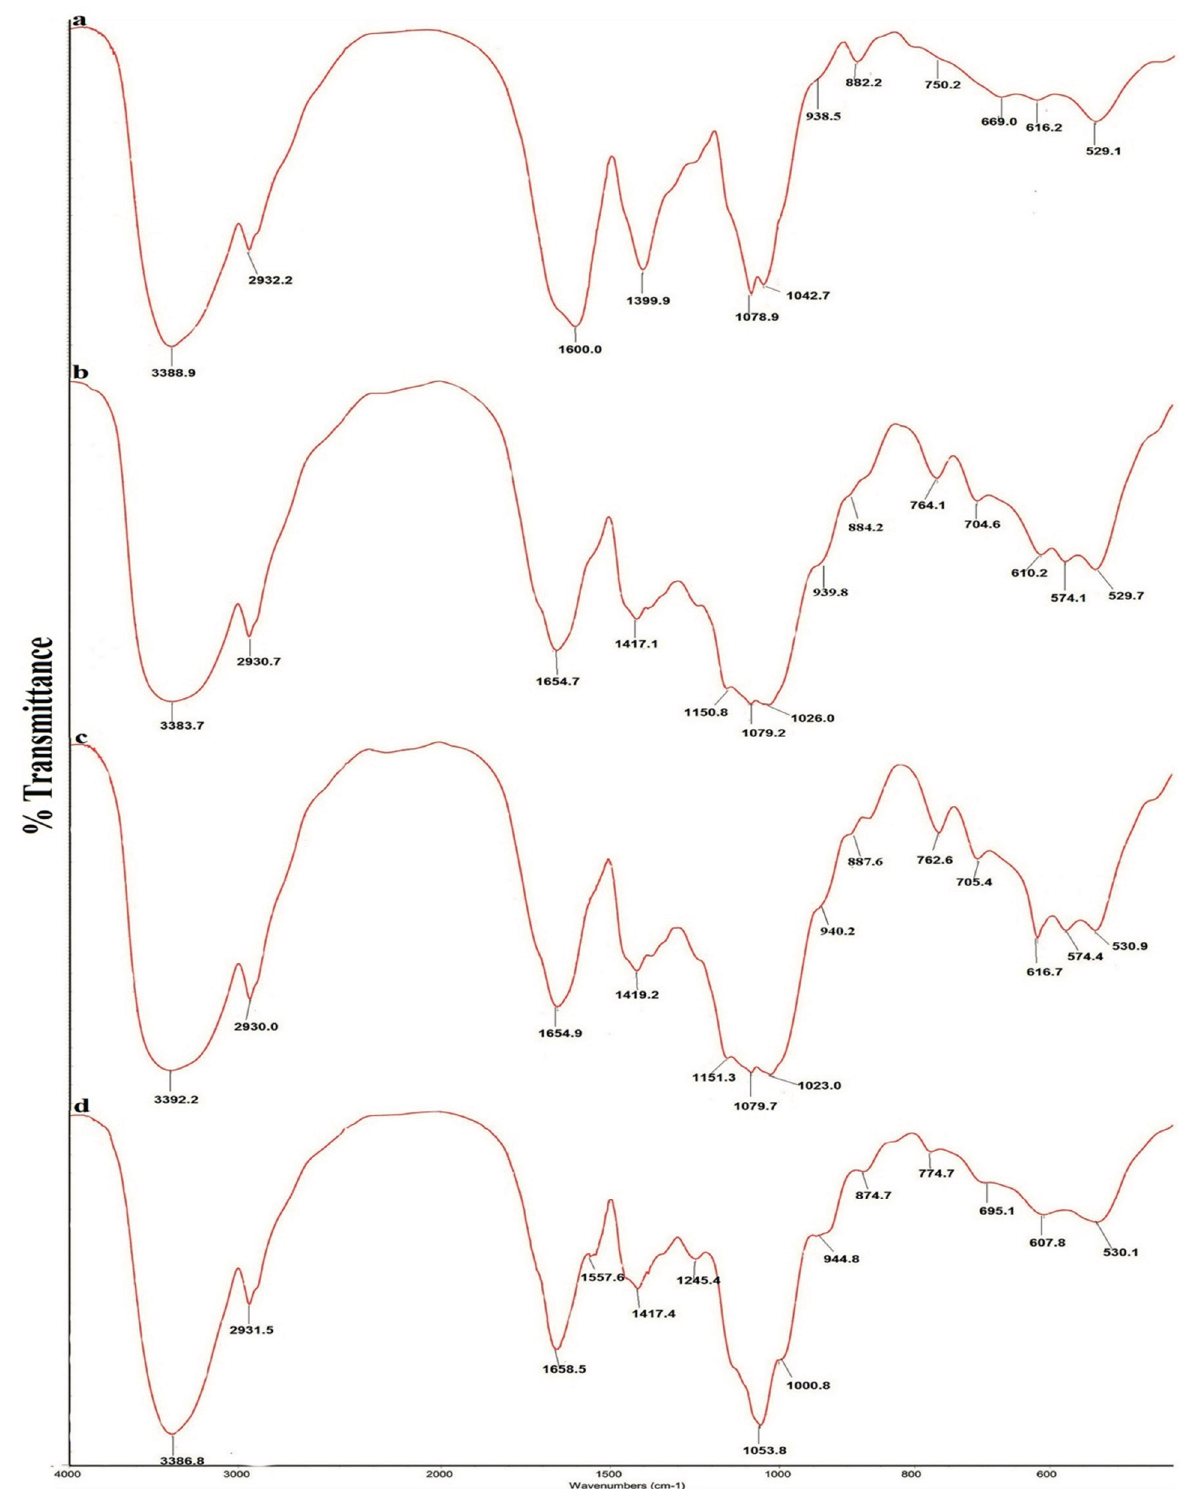
Figure 1. FT-IR spectra of four polysaccharides from Armillaria mellea . (a) SP; (b) CMP; (c) CFMP; (d)